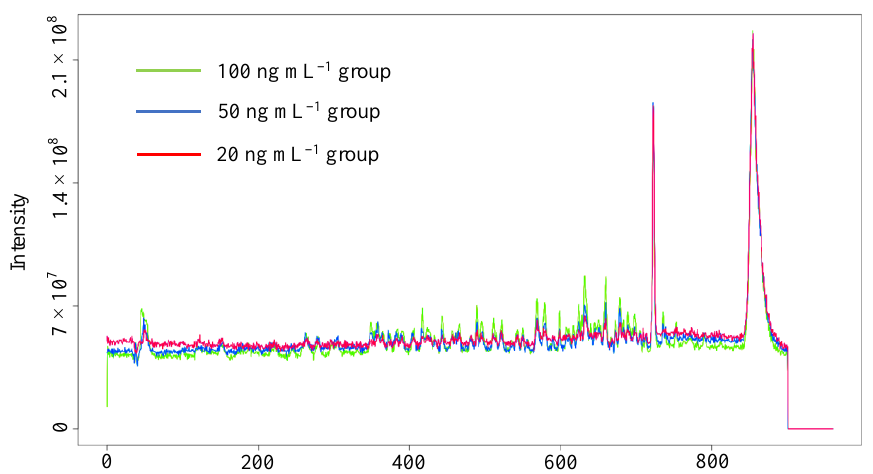
Figure 1. Total ion chromatograms (0~900 s) of spiked lettuce sample groups on the W4M platform.